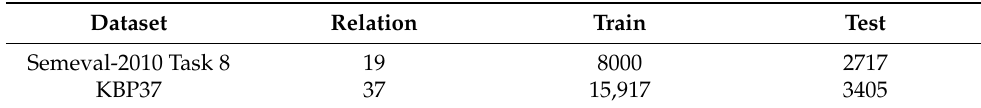
Table 4. Statistics of Semeval-2010 Task 8 and KBP37 datasets. Dataset Relation